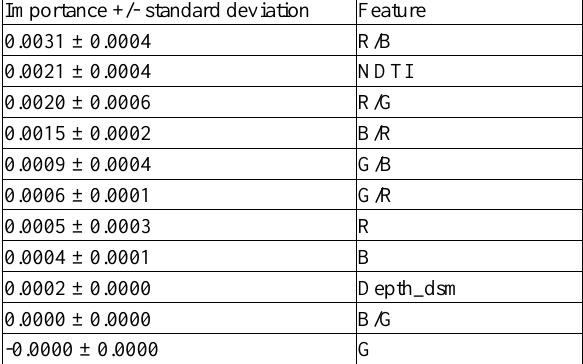
Table 4. Results of the permutation analysis on the ANN model, considering the negative mean squared error